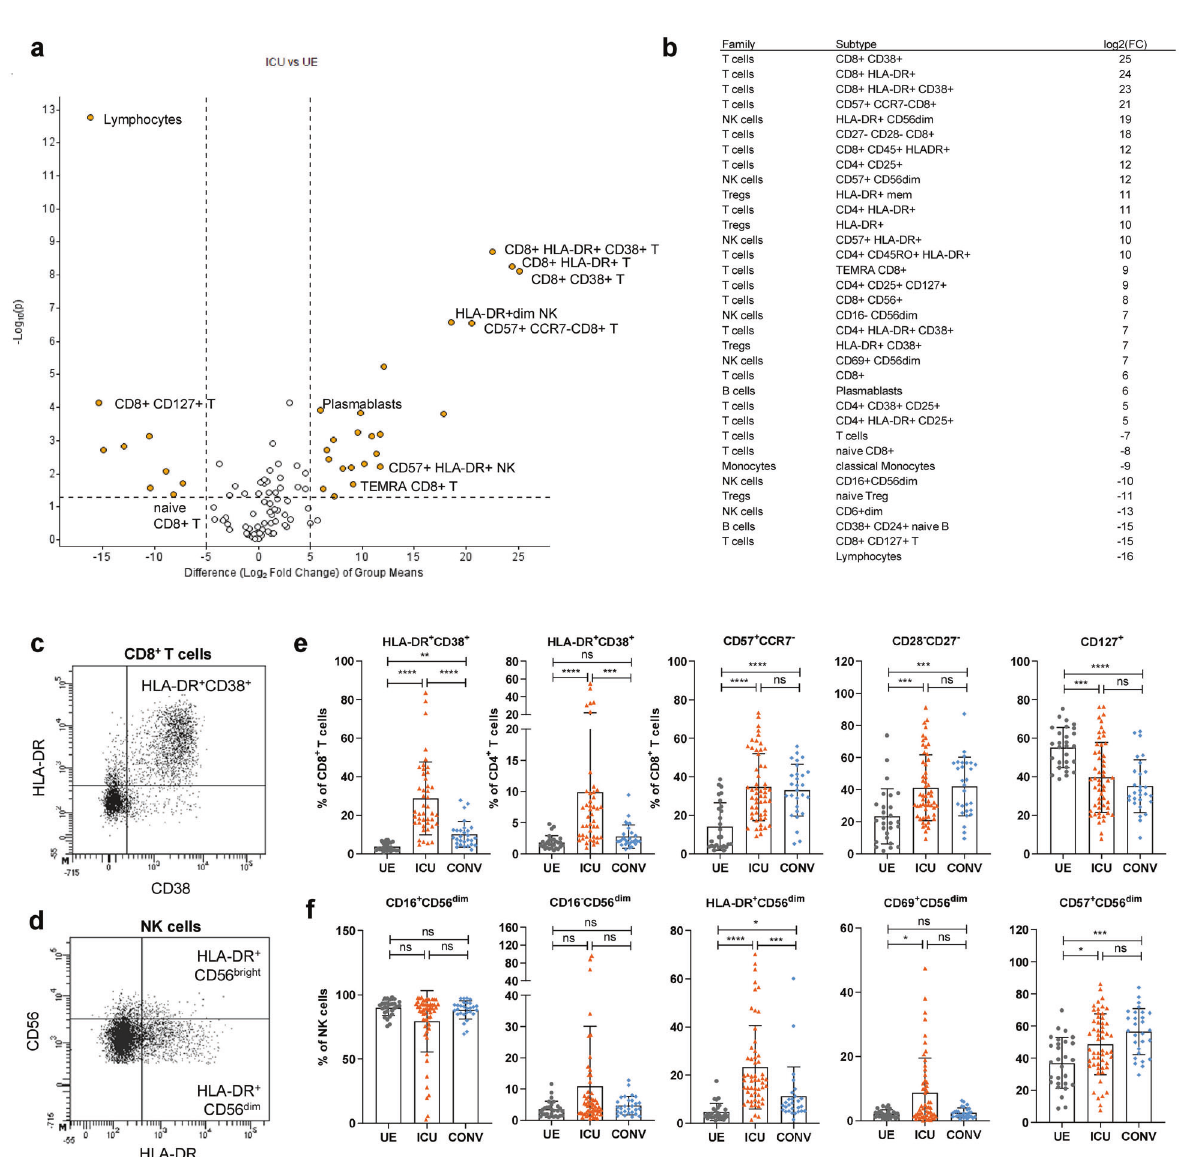
Fig. 3 Expansion of activated and terminally differentiated T and NK cells in COVID-19 ICU patients. a Volcano plot visualizing two-group comparison of fl ow cytometry data including proportions of immune cells from ICU ( n = 58) and UE ( n = 29). b Signi fi cantly ( P ≥ 0.05) altered immune cell subsets between ICU ( n = 58) and UE ( n = 29) ordered based on their fold change. c , d Representative fl ow cytometry plots. e , f Representative fl ow cytometry data of immune cell frequencies from UE ( n = 29), ICU ( n = 58) and CONV ( n = 28). Statistical analysis: multigroup comparison was performed using ANOVA test with Turkey multiple comparison test or Kruskal – Wallis with test with Dunn ’ s multiple comparison test; * P < 0.05, ** P < 0.01, *** P < 0.001, **** P <